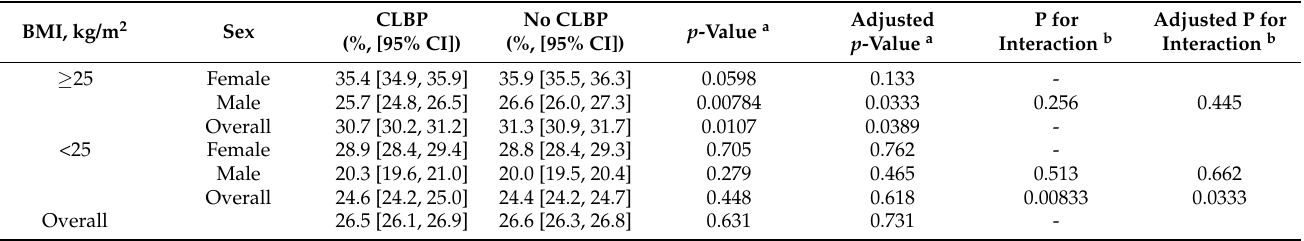
Table 3. Estimated Marginal Average of Fat Proportion against Body Weight by CLBP Status.